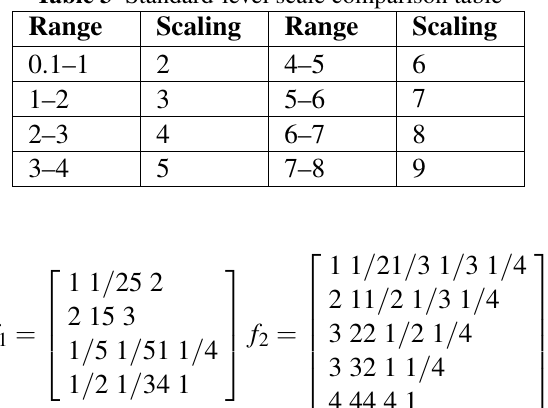
Table 3 Standard-level scale comparison